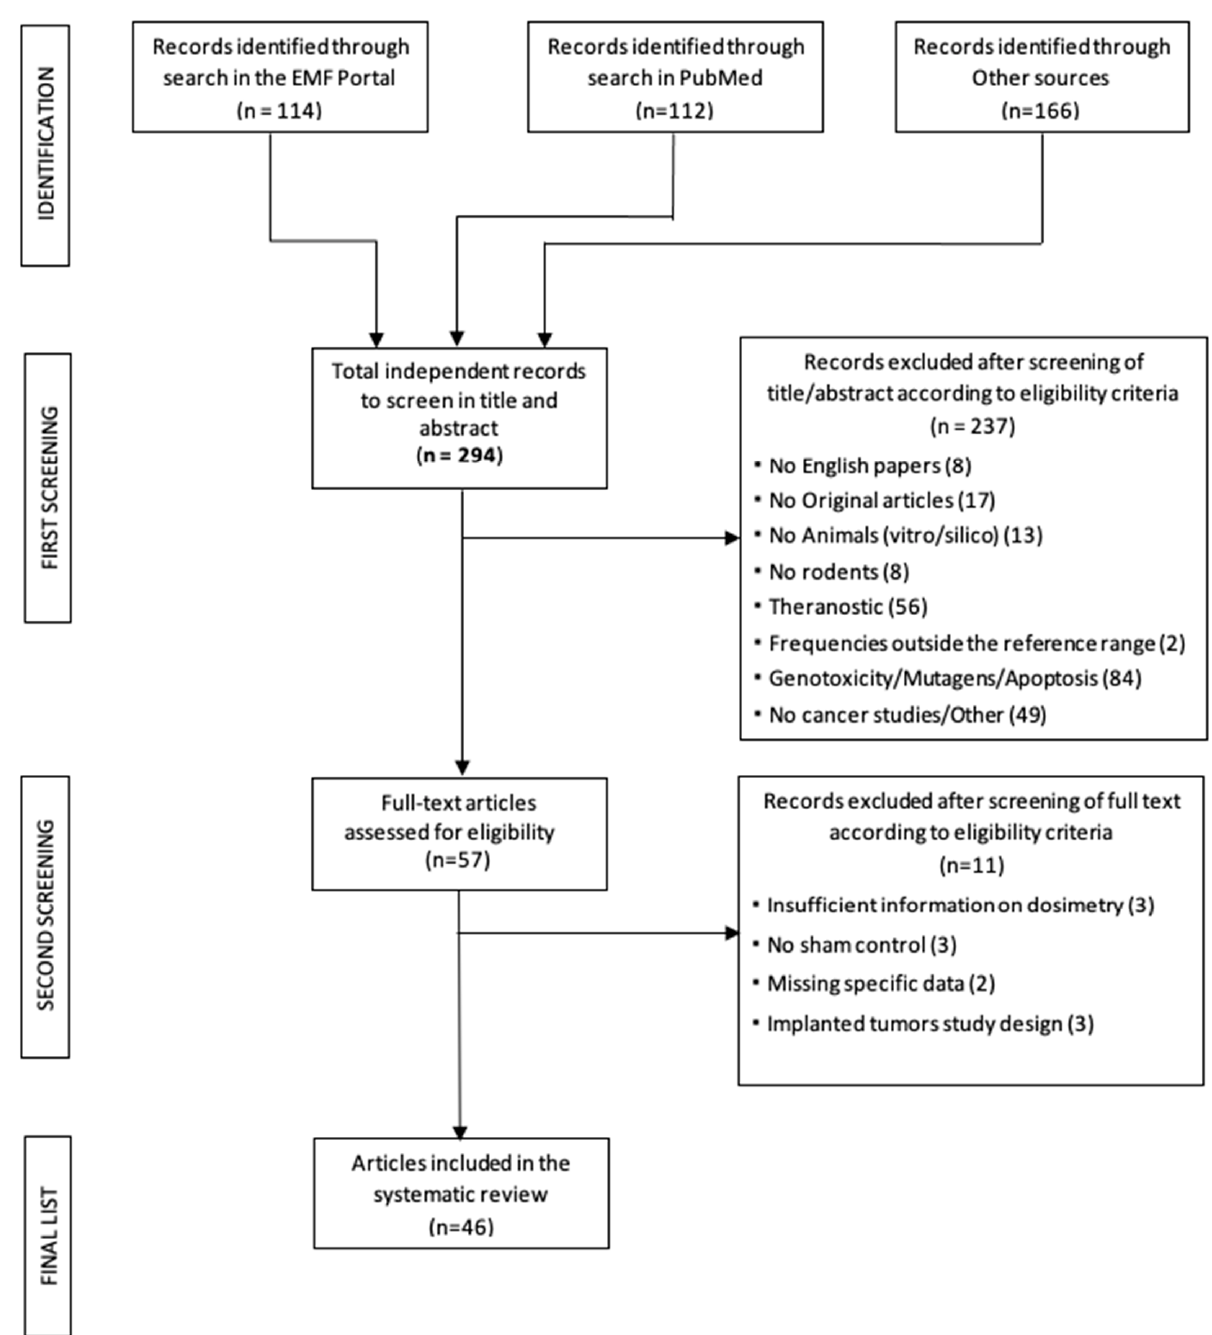
Figure 1. Flowchart of search strategy and selection process.